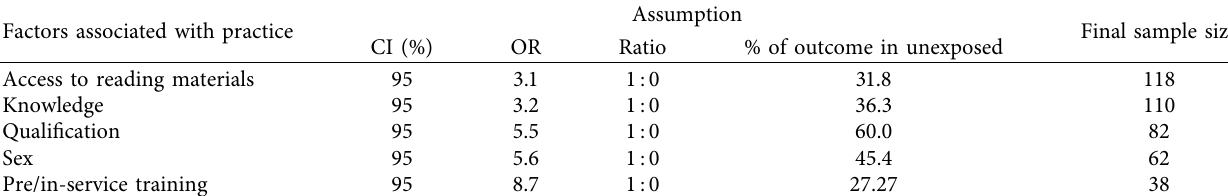
Table 1: Sample size determination using Epi Info for factors associated with